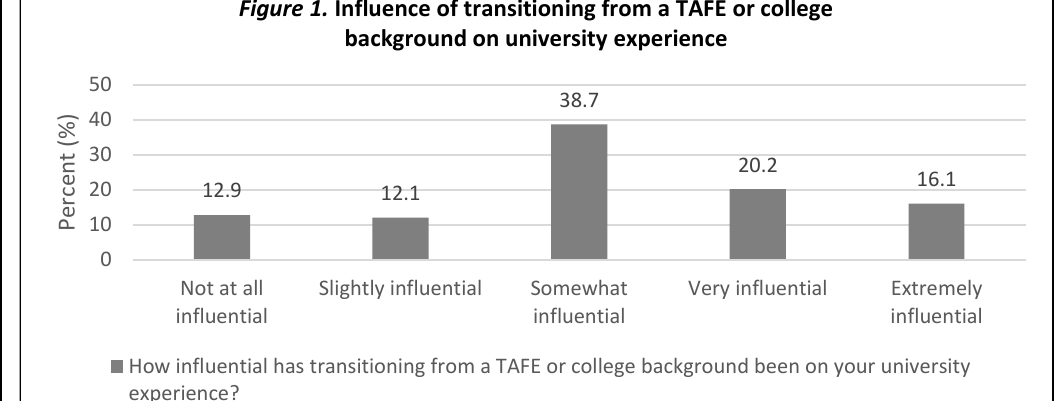
Figure 1. Influence of transitioning from a TAFE or